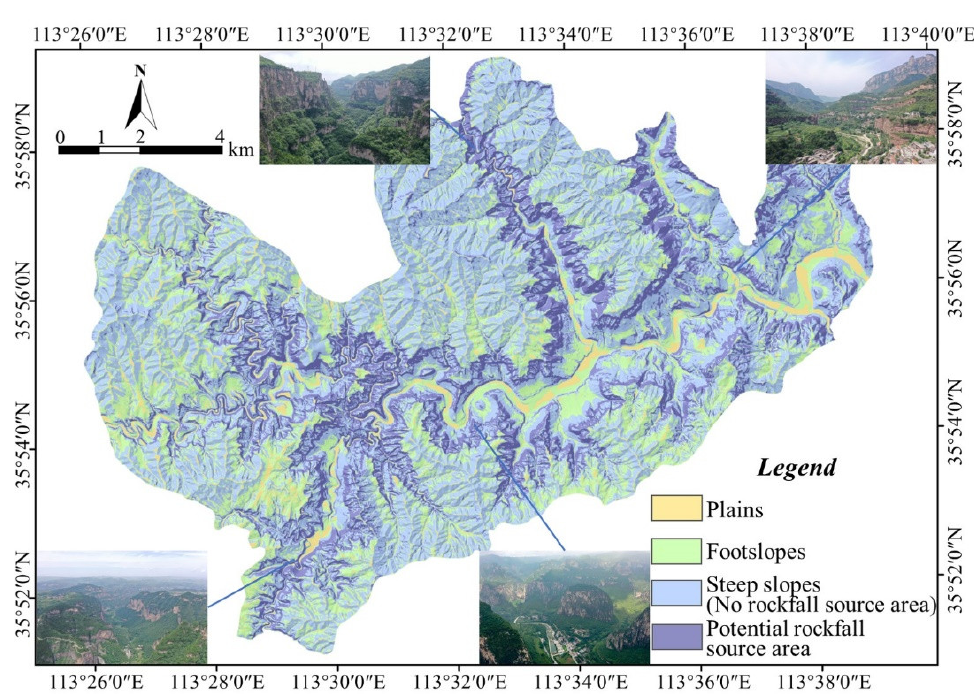
Figure 13. Static identification results of potential rockfall source areas in the Taihang GCSA.